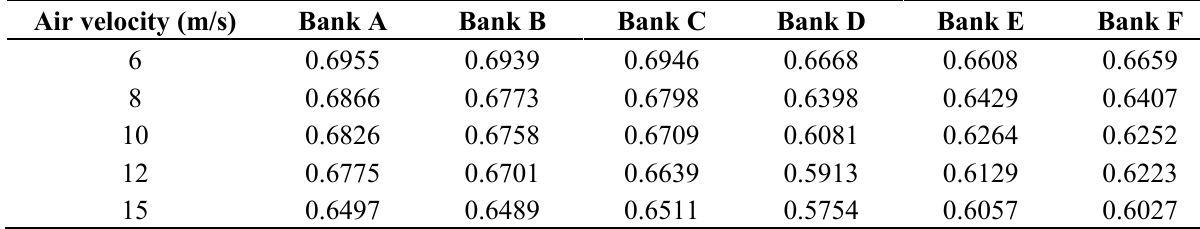
Table 2. Experimental fin efficiency